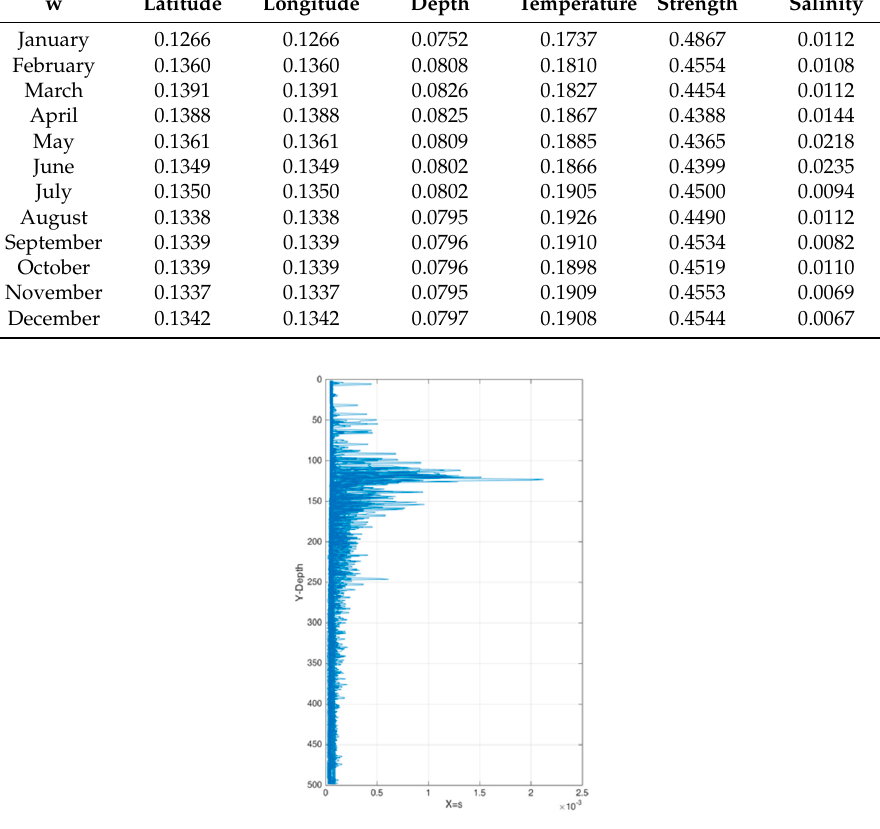
Figure 12. Weights s of each point from sea surface to 500 m underwater.